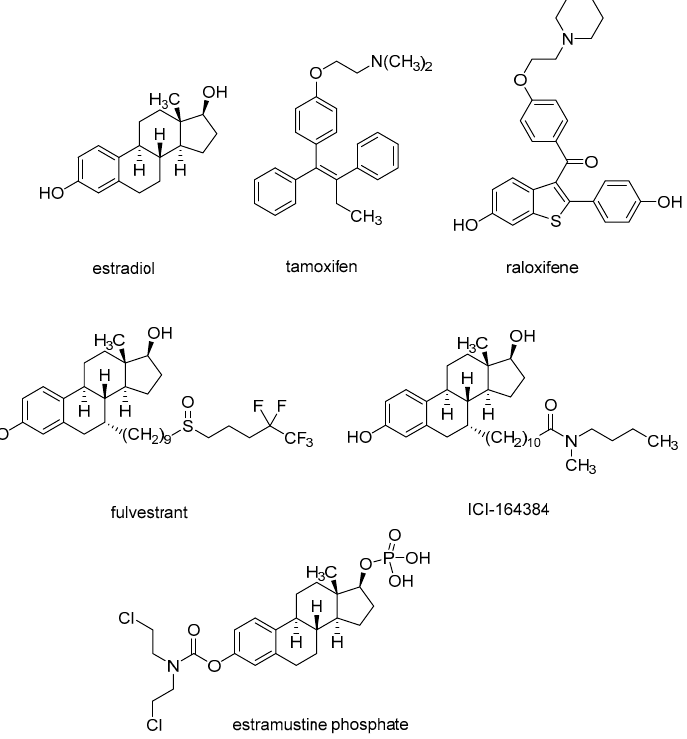
Figure 1. Structures of estrogen receptor ligands and estramustine phosphate.